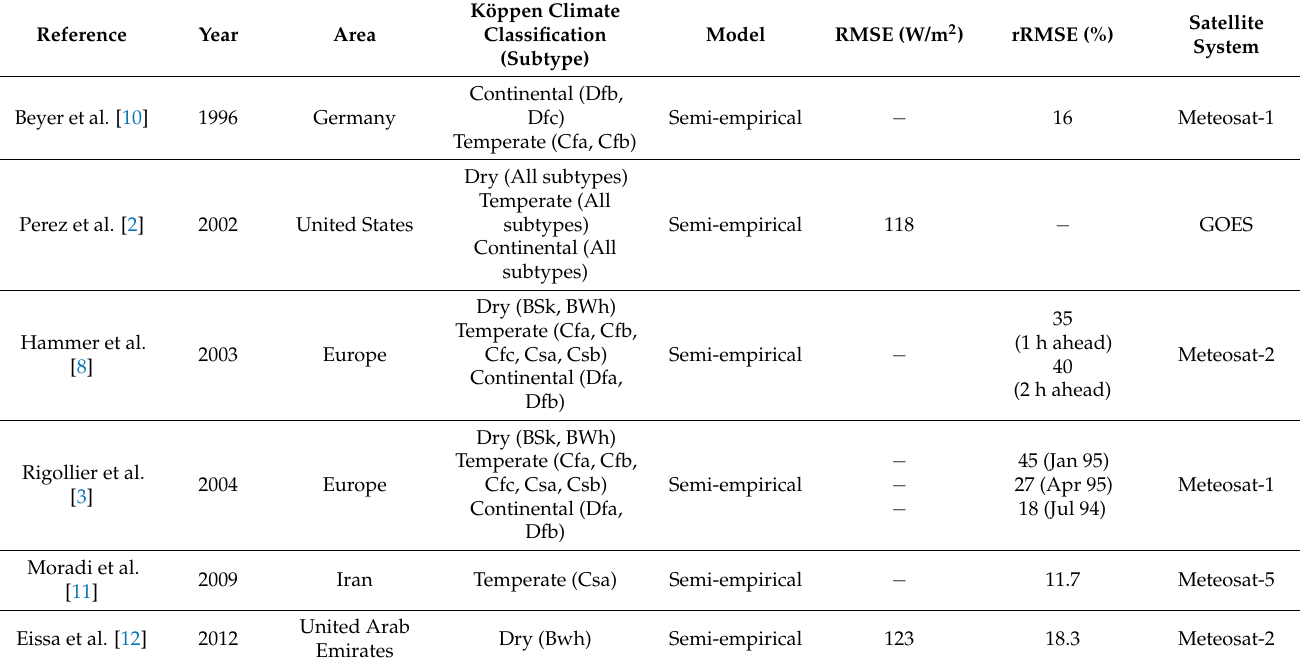
Table 1. Summary of semi-empirical and physical models using satellite images to estimate solar irradiance.